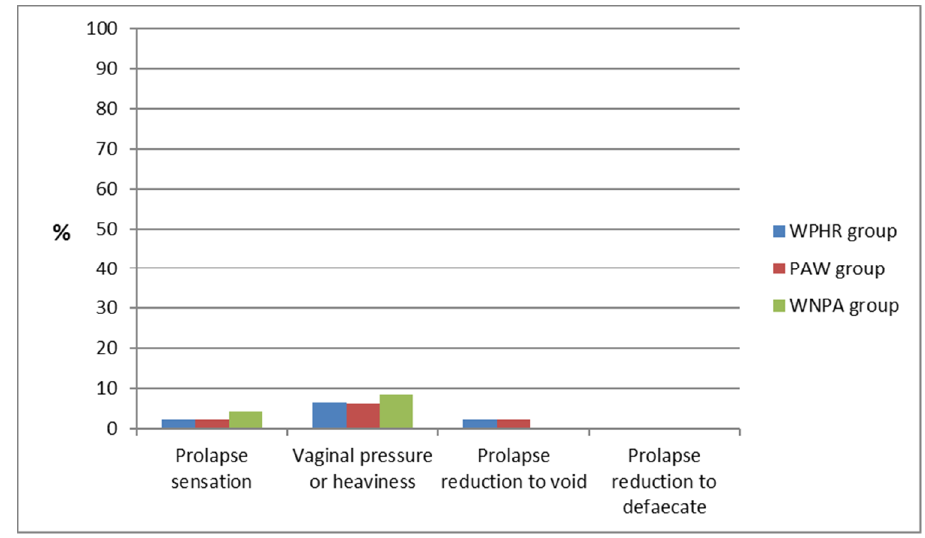
Figure 4. Occurrence of prolapse symptoms by groups.